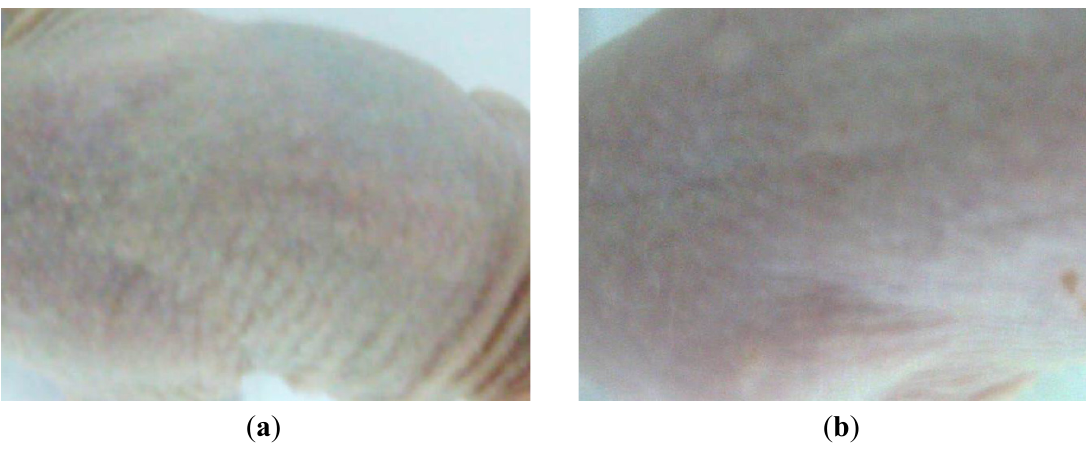
Figure 13. Skin macroscopical differences for: ( a ) control mouse; ( b ) OA:UA:HPGCD treated mice, after